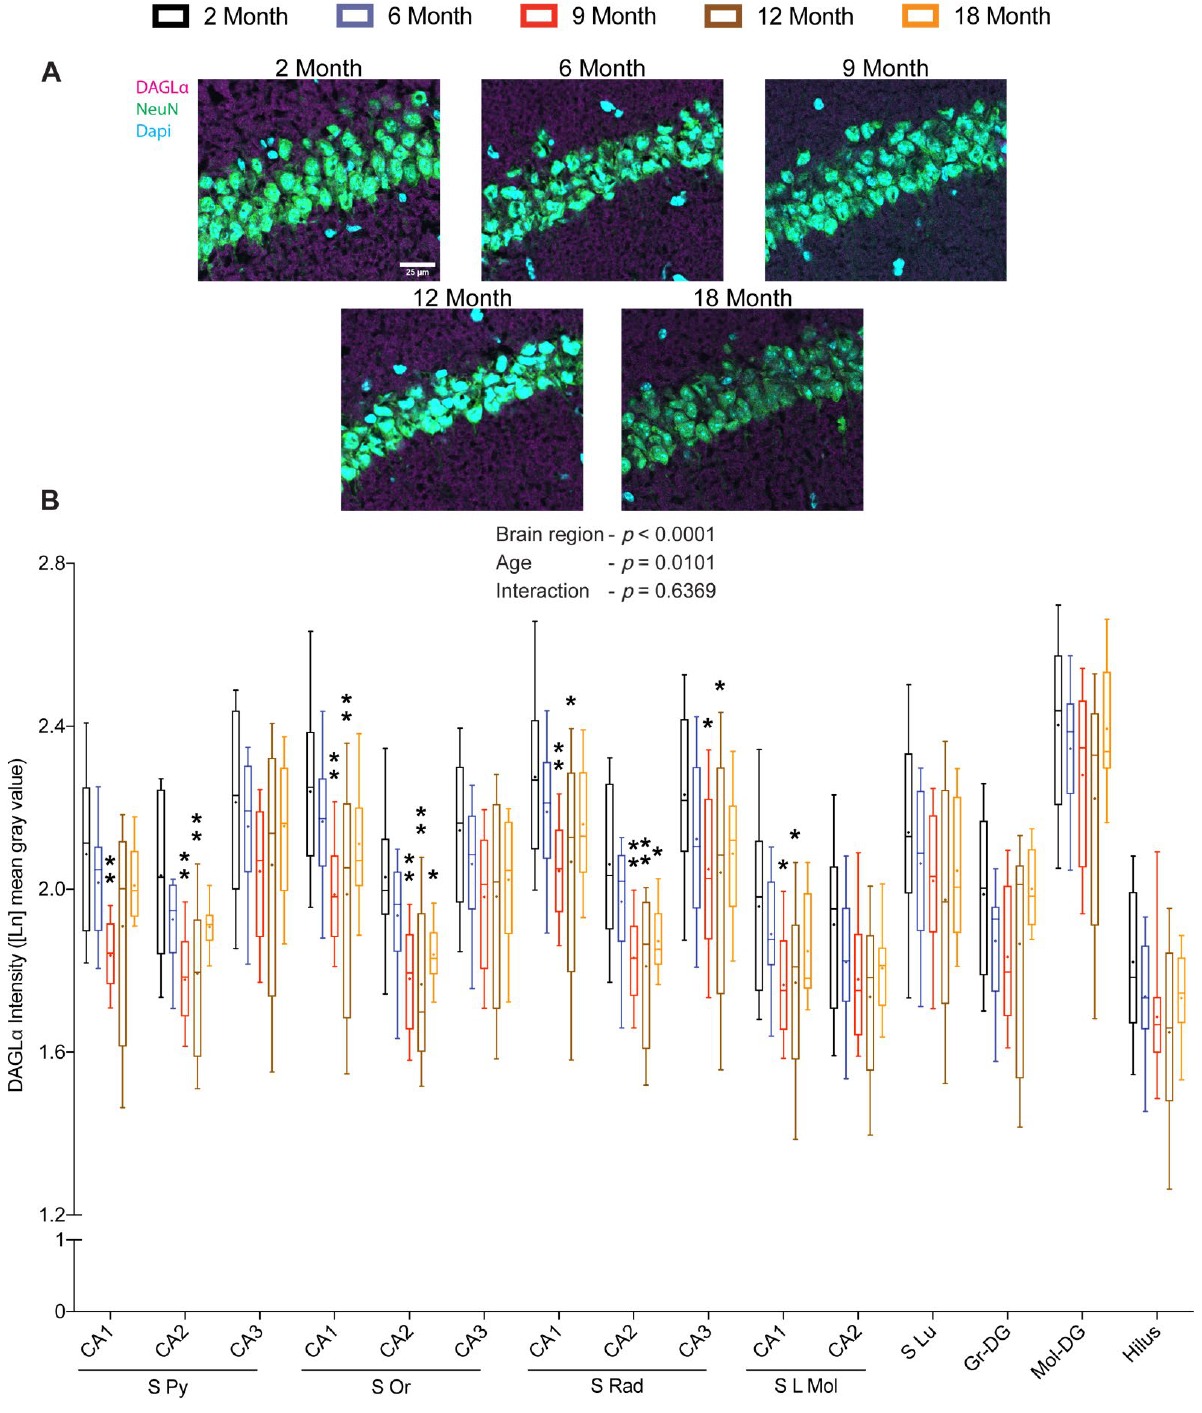
Figure 2. Effect of age on DAGL α protein levels within hippocampus. Coronal brain sections of 2-, 6-, 9-, 12- and 18-month-old mice immunostained for DAGL α . Representative images depicting DAGL α immunoreactivity in the CA1 region (scale bar = 25 μm) ( A ). Quantification of DAGL α immunoreactivity across hippocampal sub-regions revealed significant changes in DAGL α protein levels with respect to age and brain region ( B ). ( n = 12 images were analyzed from four mice per age group). Whiskers represent minimum and maximum values; + symbol within the box indicates mean; * p < 0.05; ** p < 0.01; linear mixed model analysis followed by Dunnett ´ s multiple comparison test. p -values refer to pairwise tests against the 2-month-old